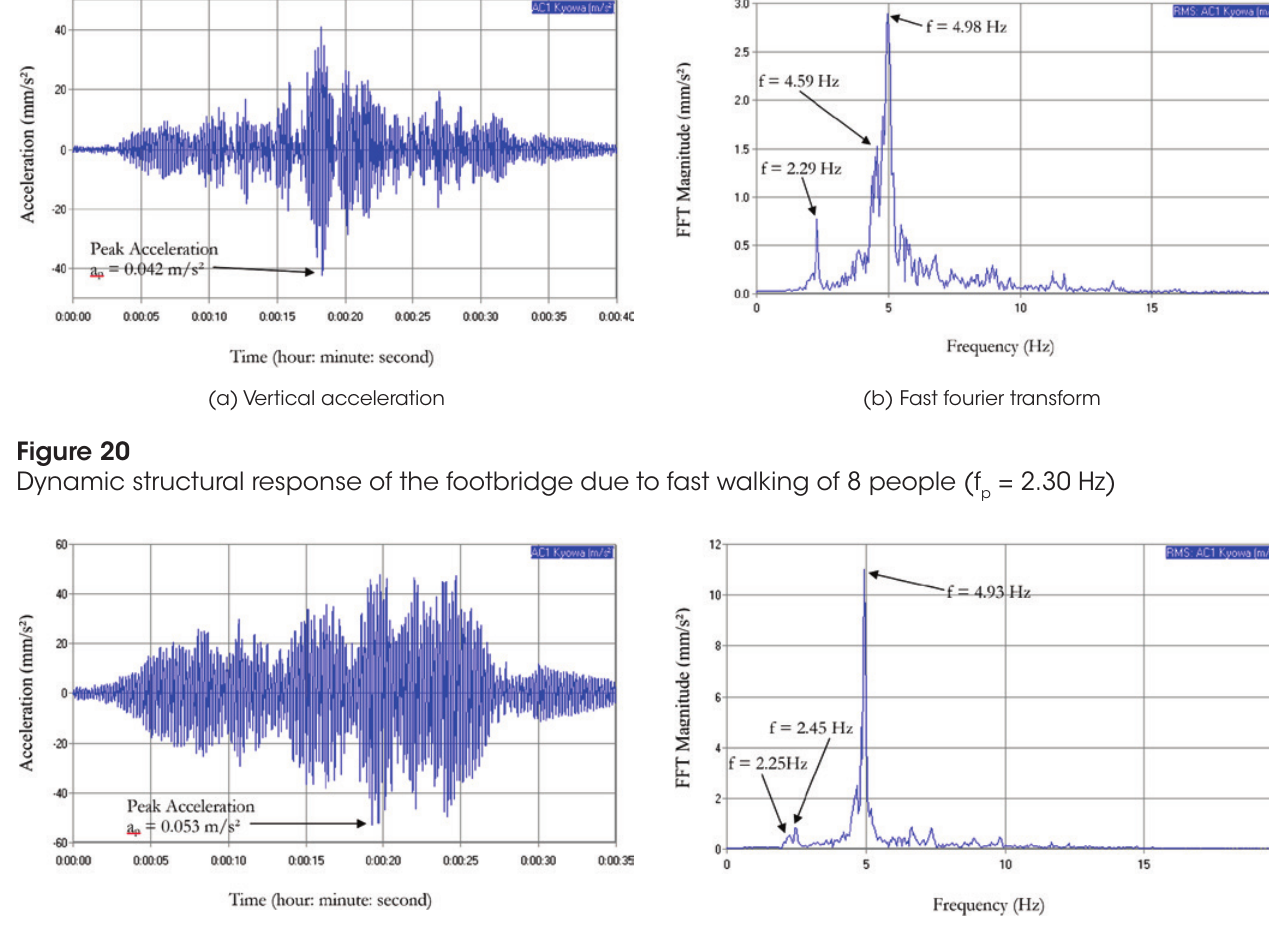
(b) Fast fourier = 2.45 Hz) p